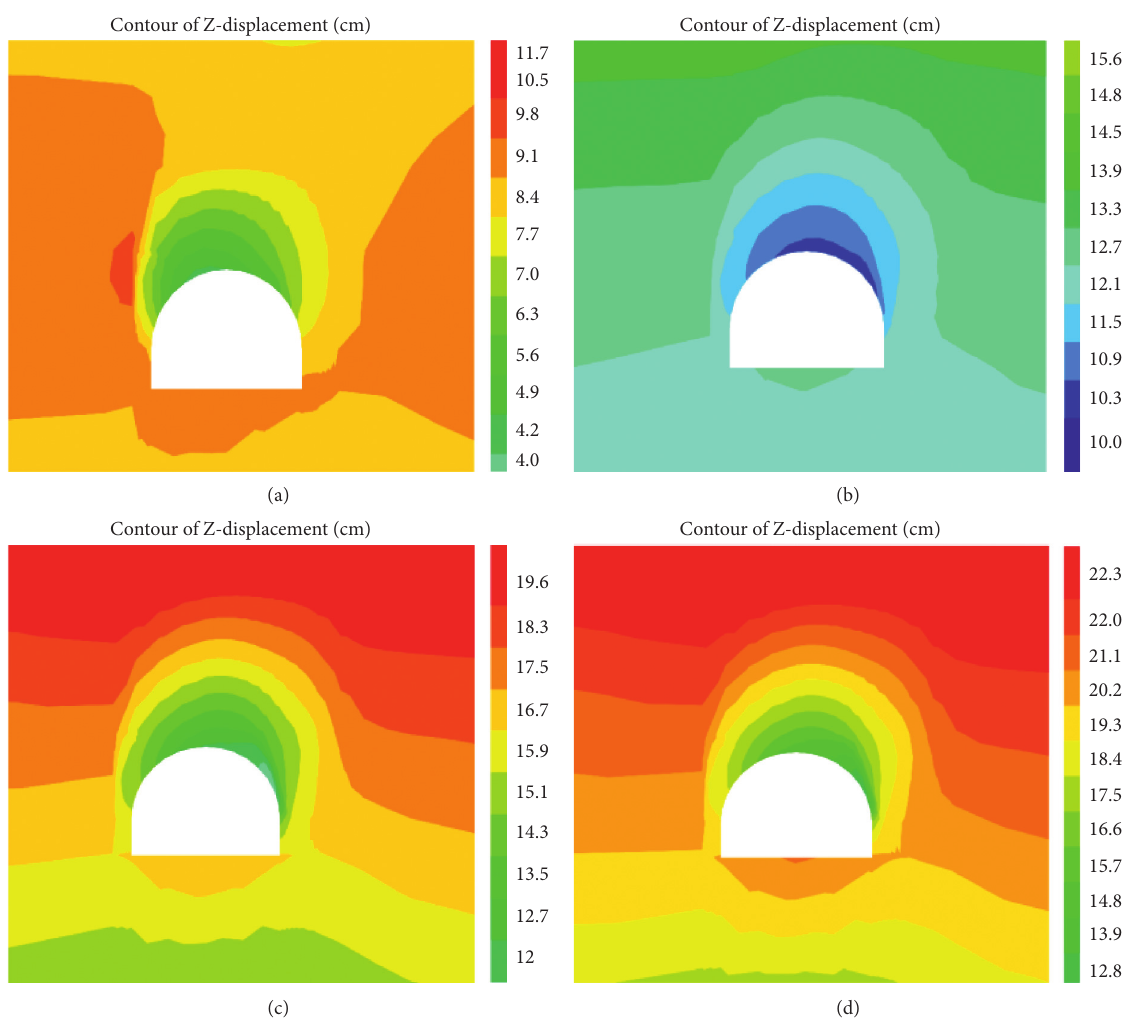
Figure 12: Diagram of displacement change of the surrounding rock of the roadway before reinforcement: (a) working face advancing 12m, (b) working face advancing 36m, (c) working face advancing 60m, and (d) working face advancing 84